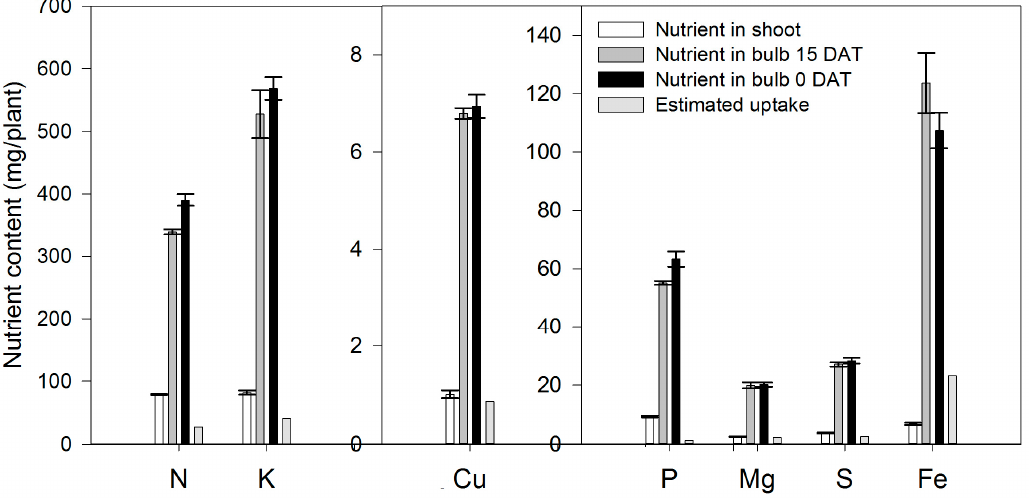
Figure 2. Total nutrient content in the shoot (leaves + stem) and in the bulb of lilium plants at 15 days after transplant (15 DAT) and at transplant time (0 DAT). Estimated uptake was calculated by the difference between the nutrient content in the shoot and the change in nutrient content in the bulb from 0 to 15 DAT. Bars represent the standard error of the mean. Table 1. Total macronutrients accumulated by lilium plants (mean ± standard error) at the end of the growing season and the amount provided by the bulb or absorbed from the growing medium.